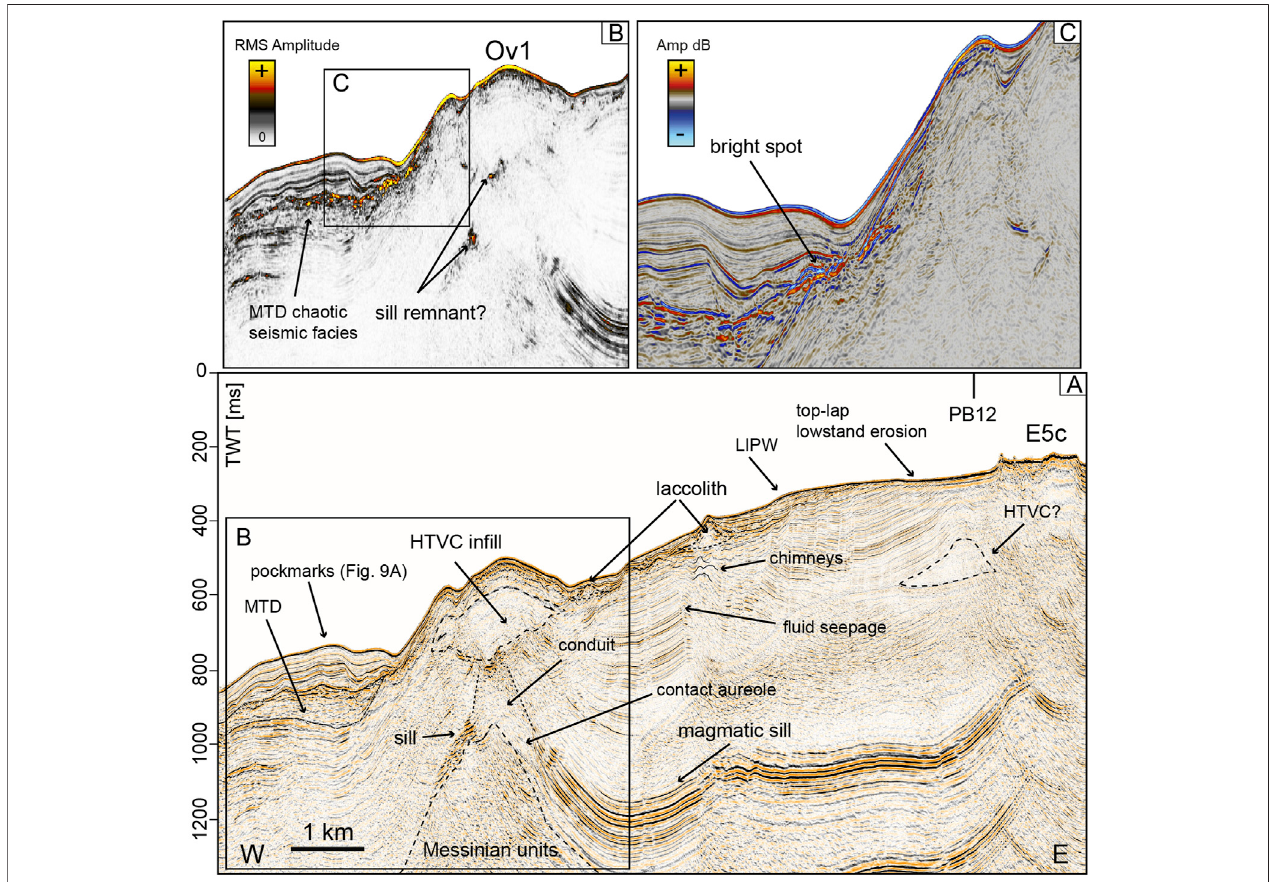
FIGURE 4 | (A) Seismic re fl ection pro fi le PB02 showing the volcanic edi fi ces of Ov1 and E5c with the hydrothermal vent complex (HTVC) located below Ov1 and theinferredextinctHTVCbelowE5c.ThediapirismofMessinianunitsisalsotracedhighlightingaconduitfeedingtheHTVC.BaseandtopofanMTDlocateddownslope of Ov1 are outlined. (B) RMS Iterative amplitude extracted from the pro fi le portion outlined in (A) showing possible remnants of a magmatic sill and the MTD chaotic facies. (C) Close-up of the seismic line outlined in (B) , where bright spots are indicated. Location in Figure 2A .